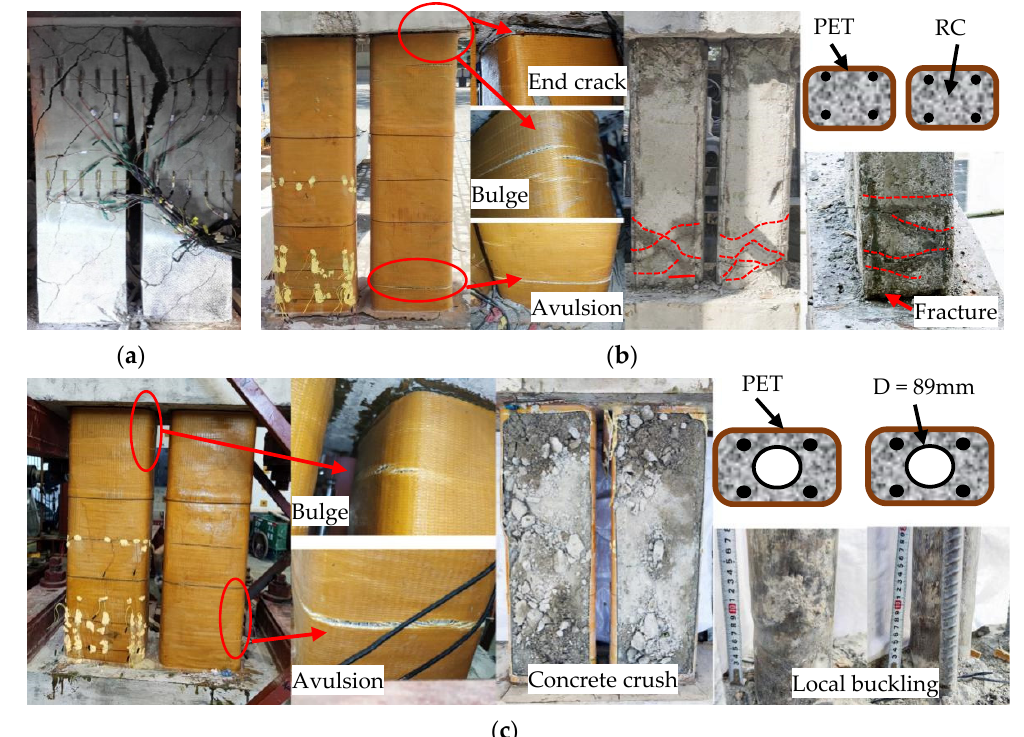
Figure 7. Failure modes of specimens: ( a ) reinforced-concrete double coupling beam (RC-DCB); ( b ) LRS-DCB; ( c ) DST-DCB-89.